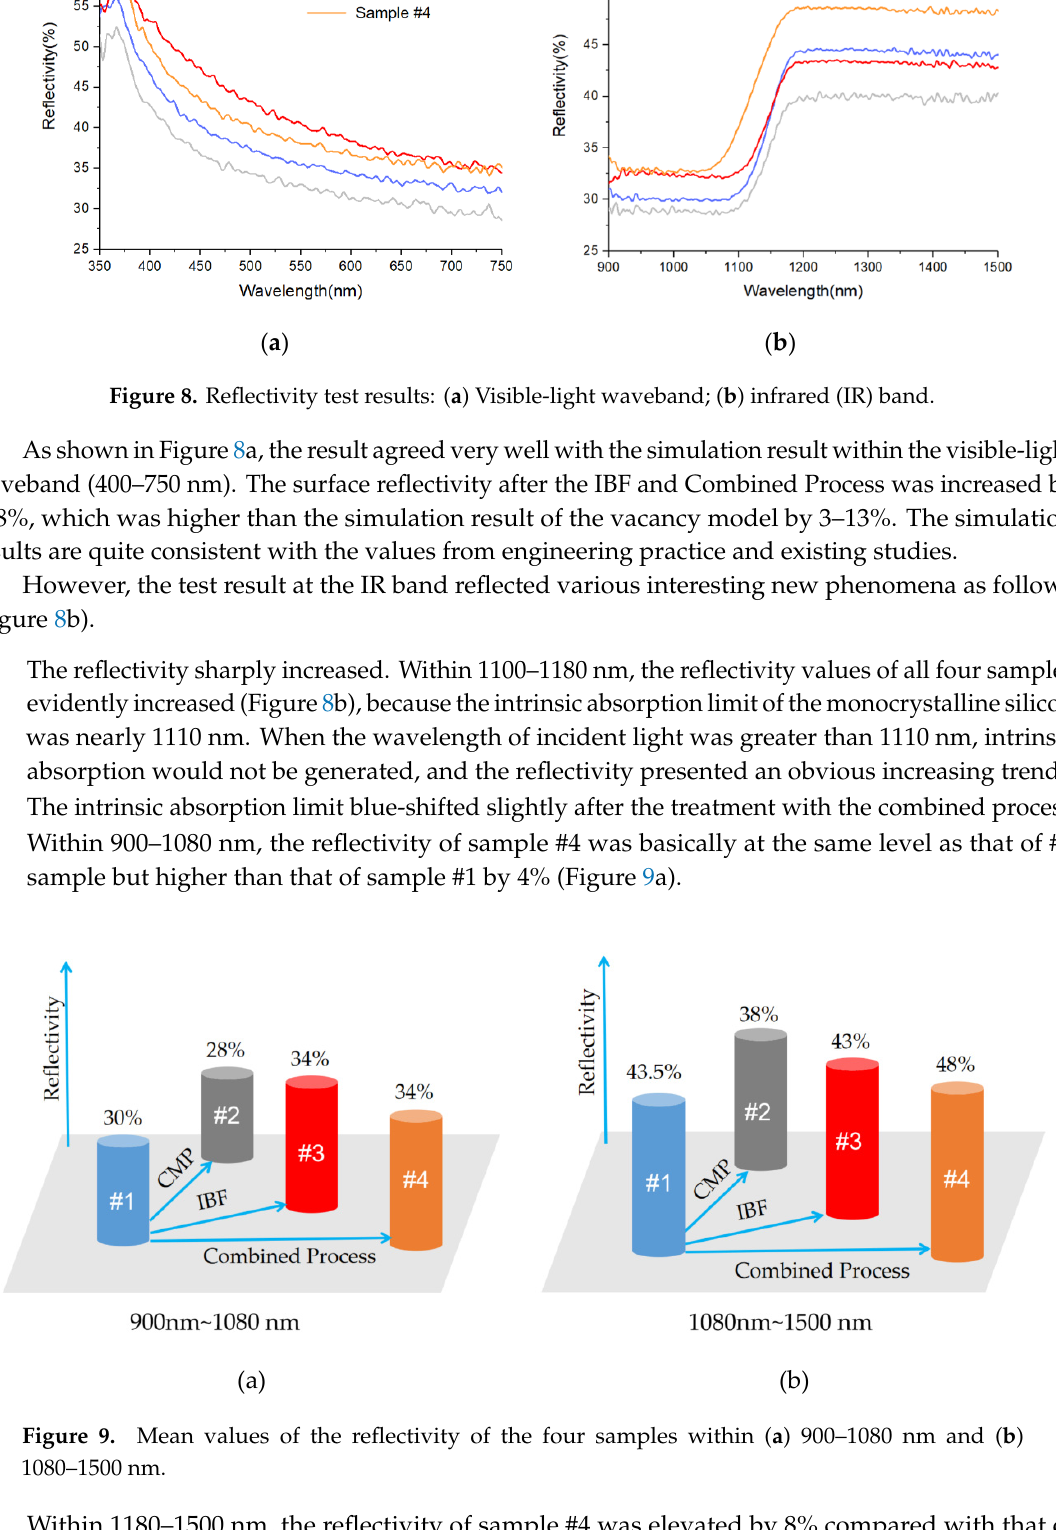
Figure 9. Mean values of the reflectivity of the four samples within ( a ) 900 – 1080 nm and ( b ) 1080 – 1500